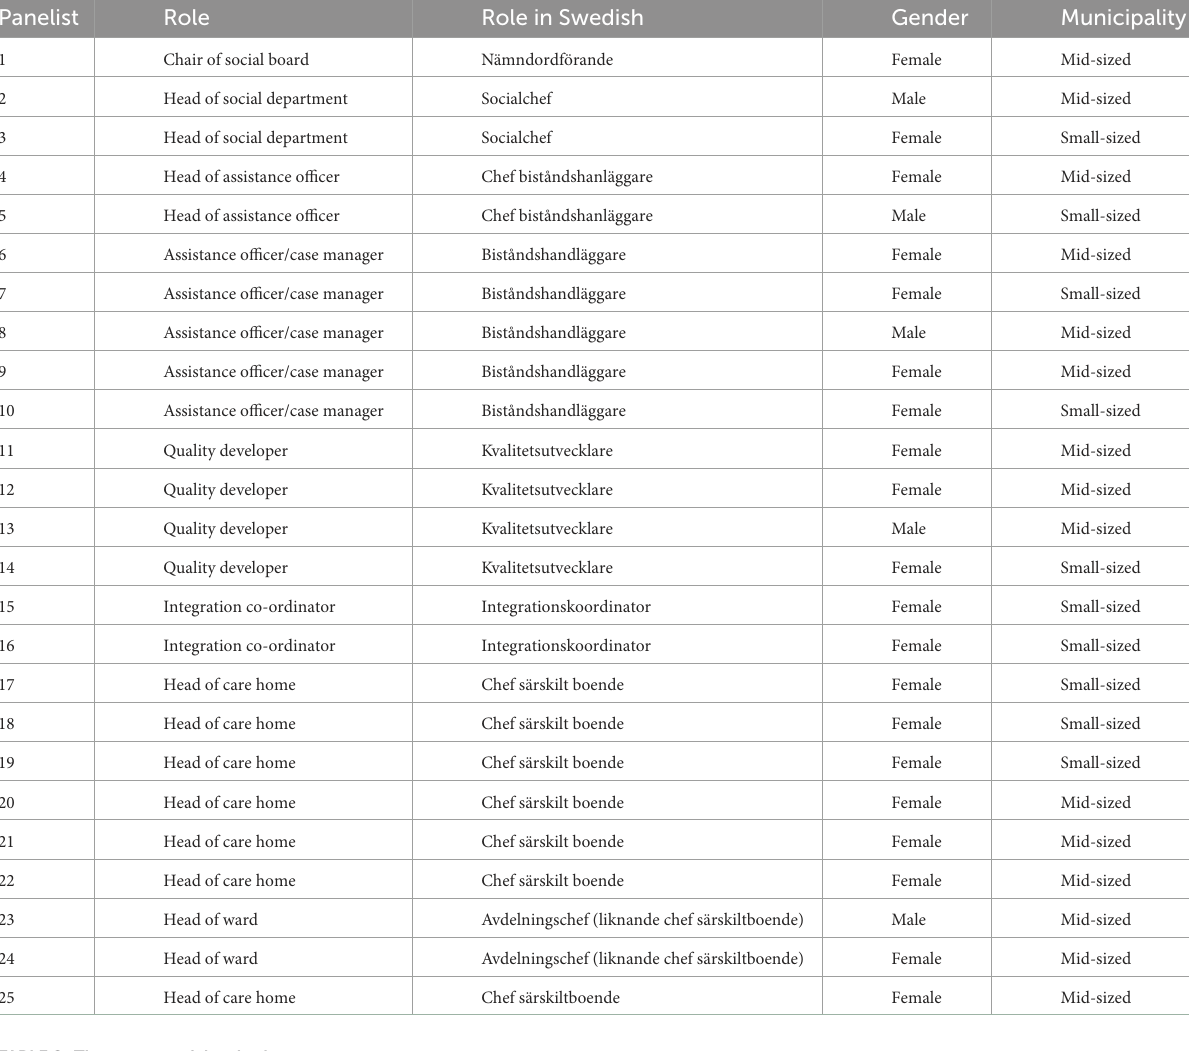
TABLE 1 Characteristics of the panelists.